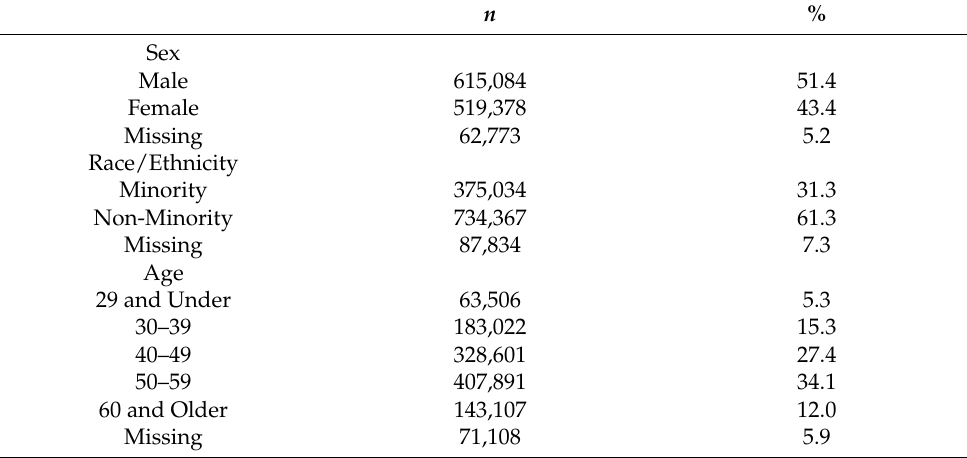
Table 1. Demographic